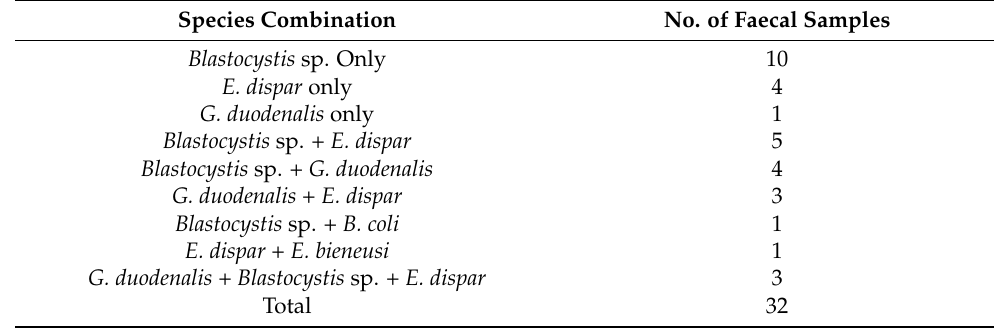
Table 2. Single and multiple enteric protist infections detected in faecal samples from captive non-human primates in the C ó rdoba Zoo Conservation Centre (Spain). Species Combination No. of Faecal